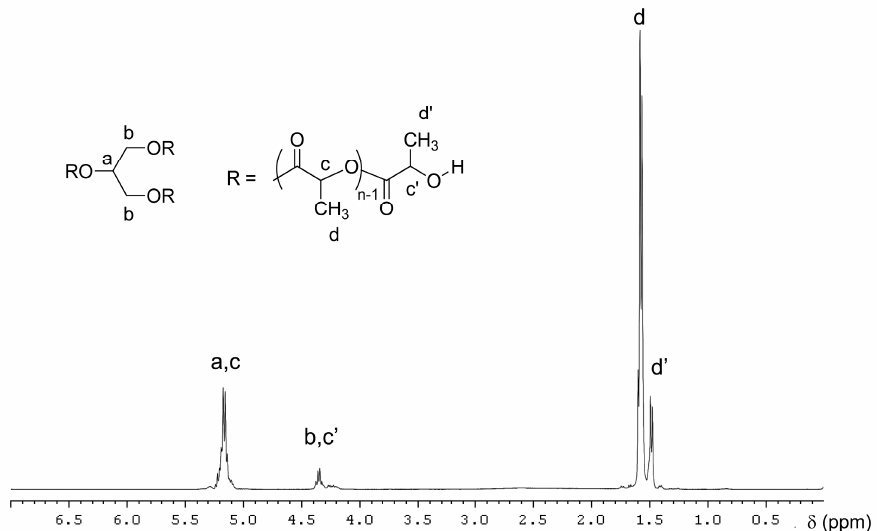
Figure 1. 1 H-NMR spectrum of H3LLAO in CDCl 3 .